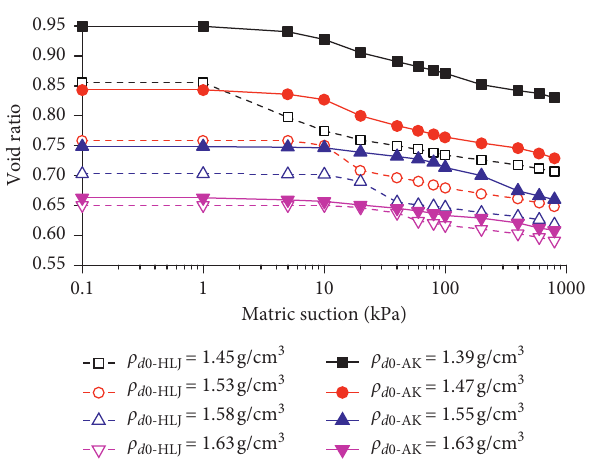
different initial dry